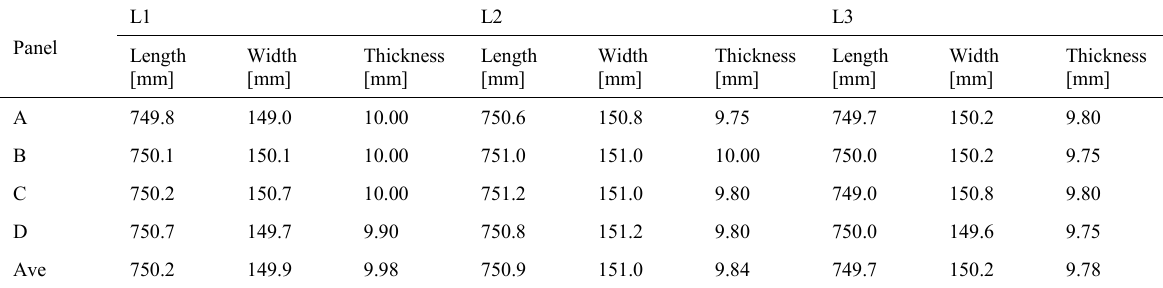
Table 1: Real dimensions of monolithic glass columns.